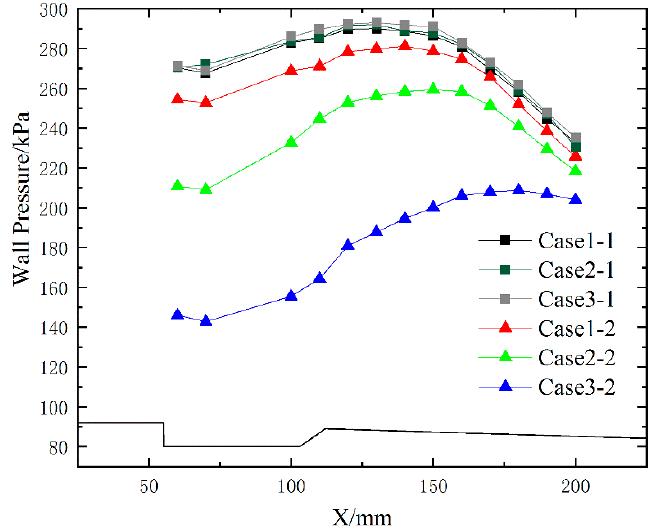
Figure 5. Distribution of the wall pressure during stable combustion before and after the condition transition.